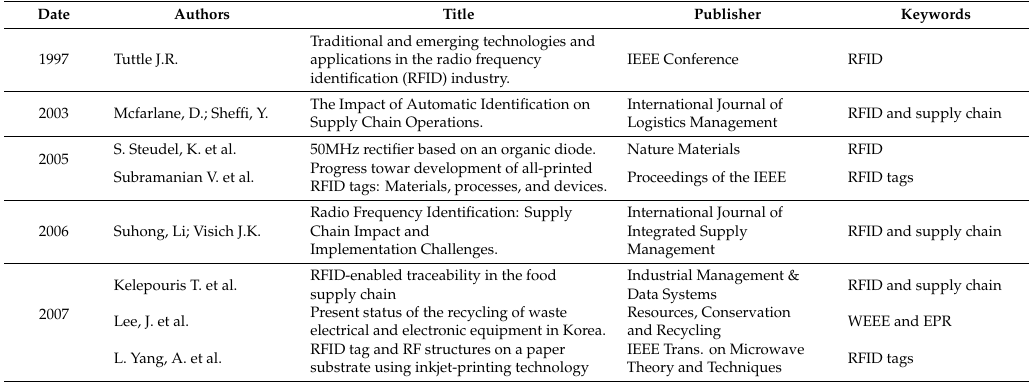
Table 1. List of considered papers, ordered by date, based on specific